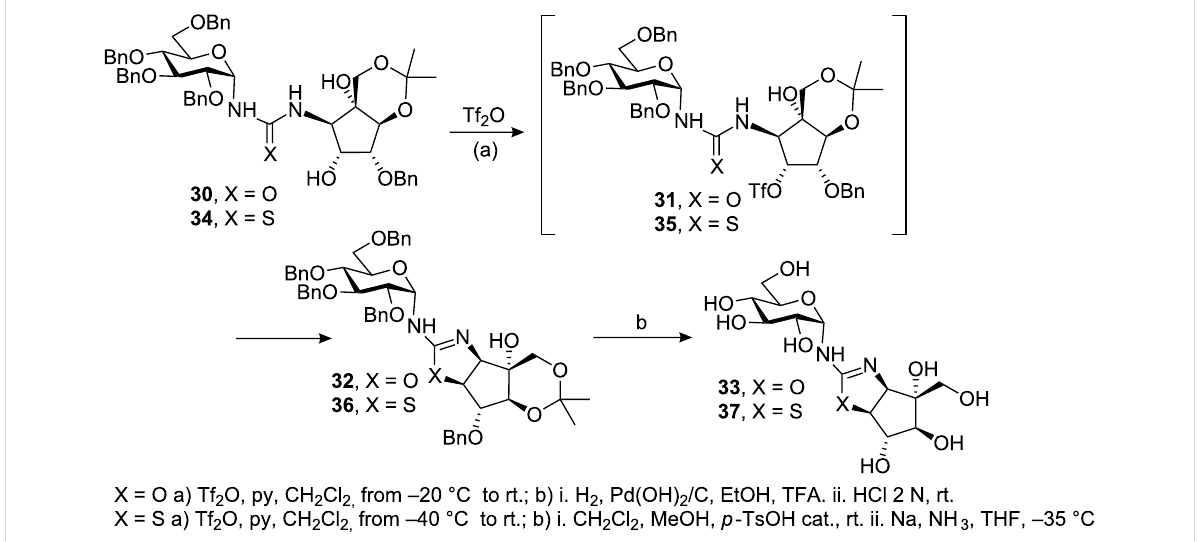
There are two general strategies to access pseudoamide-type oligosaccharide mimics: i) nucleophilic addition of sugar de- rivatives to carbohydrate isocyanates, isothiocyanates or isocy- anides; and ii) conversion of sugar azides into glycosyl carbod- iimides via a tandem Staudinger-aza-Wittig type reaction with triphenylphosphine and an isothiocyanate, followed by the add- ition of a nucleophile (H 2 O, H 2 S, NH 3 , amines) (Figure